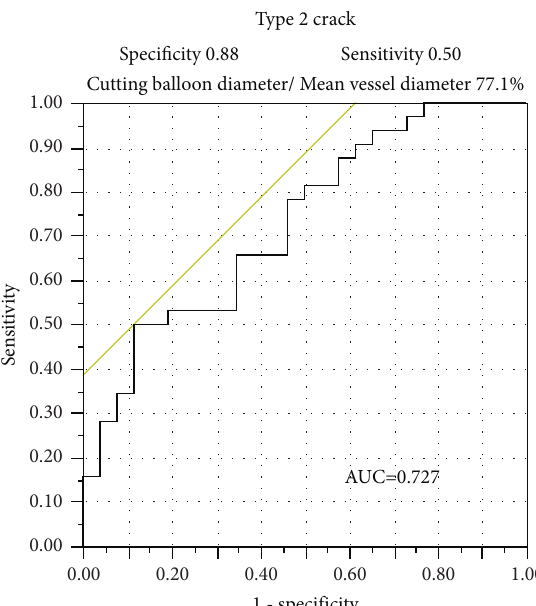
Figure 3: Receiver operating characteristic analysis for the prediction of type-2 cracks after balloon angioplasty. AUC, areas under the curve.